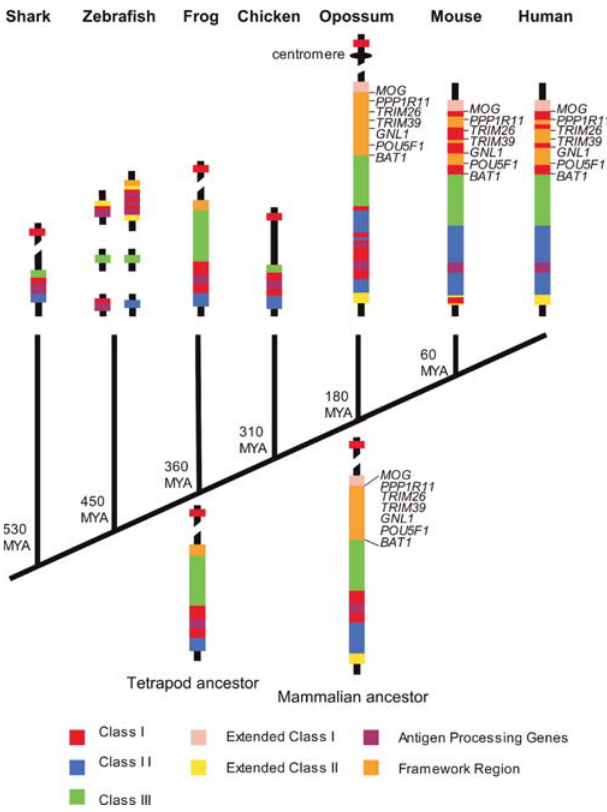
Figure 4. A Model of the Evolution of the Mammalian MHC Organization of the MHC in the mammalian ancestor is similar to that of non-mammals. Class I and II regions are adjacent and the antigen processing genes are found within Class I. Class Ib genes are located outside the MHC but on the same chromosome. The framework and extended regions have assembled. The framework gene order is conserved in both the opossum and eutherians. After the divergence of the eutherian lineage, Class I genes relocated to the framework region. MYA, million years